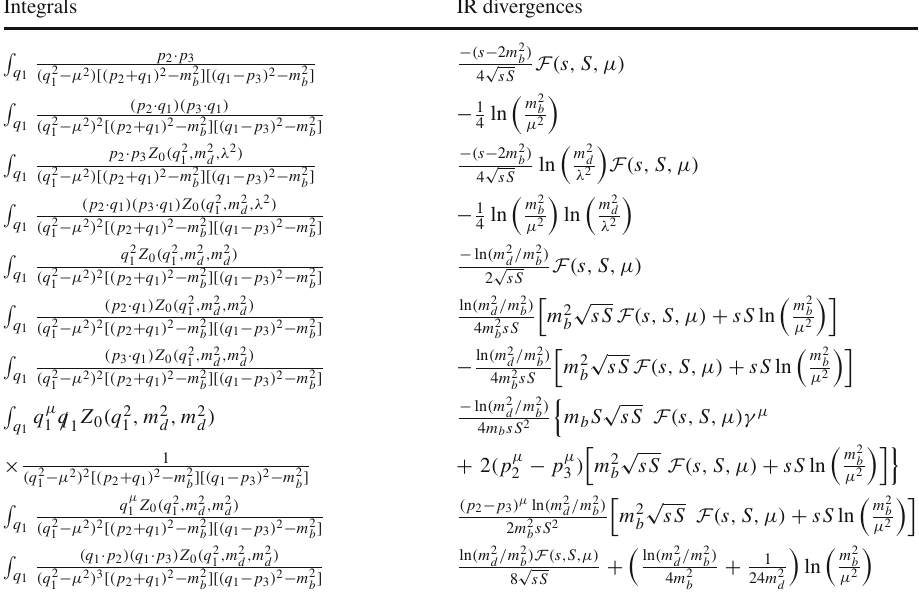
Table 1 We have denoted s ≡ ( p + p ) 2 = 2 ( p · p + m 2 ) , 2 3 2 3 b S ≡ s − 4 m 2 , F ( s , S ,μ) ≡ (cid:4) (cid:5) (cid:4) (cid:5) b − 2 μ 2 √ 2 μ 2 √ − ln 2 ln 2 sS − S sS + S , m 2 ) is defined and Z 0 ( p 2 , m 2 1 2 as in Eq.